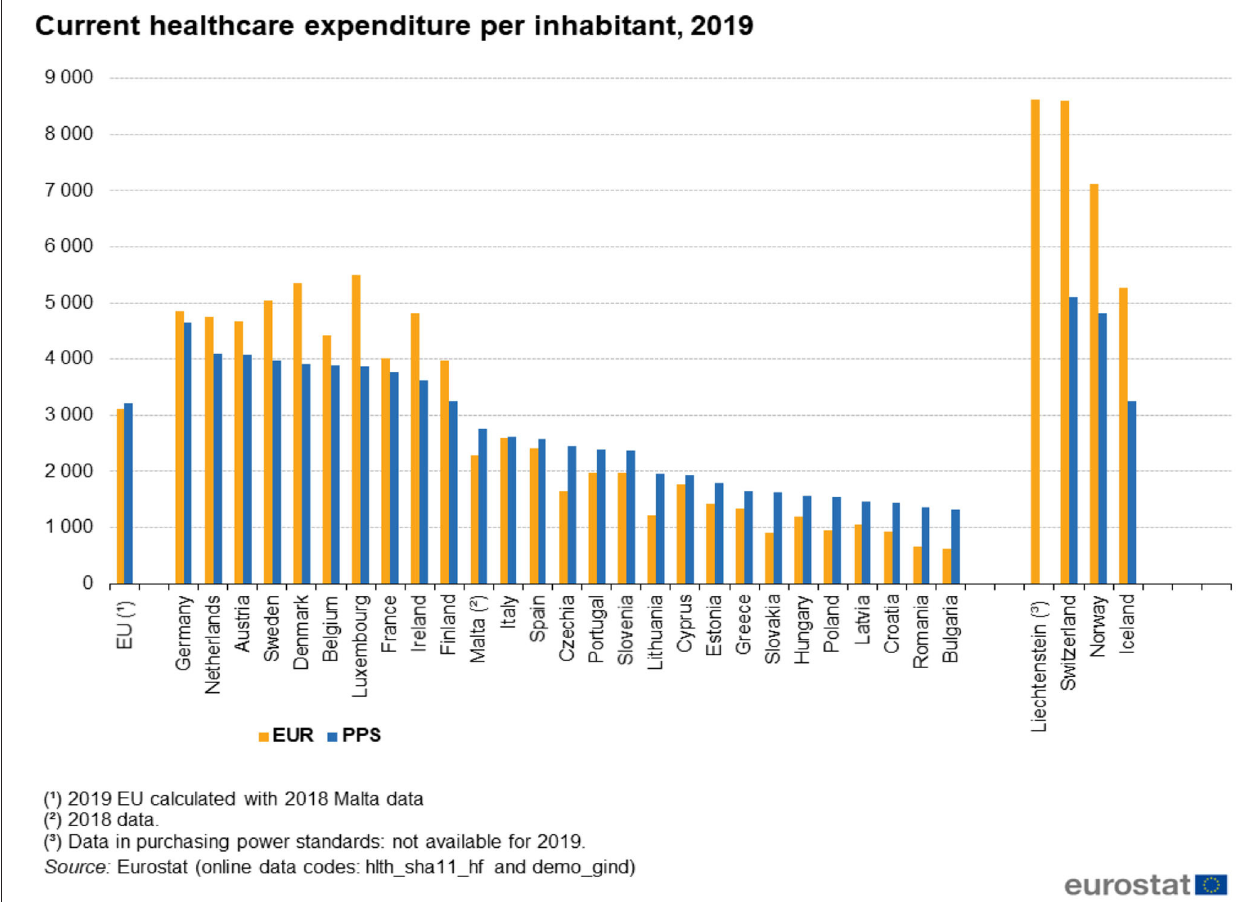
FIGURE 10 | EU current health expenditure per inhabitant, 2019 (in euros) (32). Source: https://ec.europa.eu/eurostat/statistics-explained/index.php?title= Healthcare_expenditure_statistics, accessed: